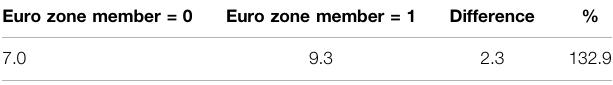
TABLE 1 | Mean of Circular Material Use Rate, by Euro area (%) (2010 –